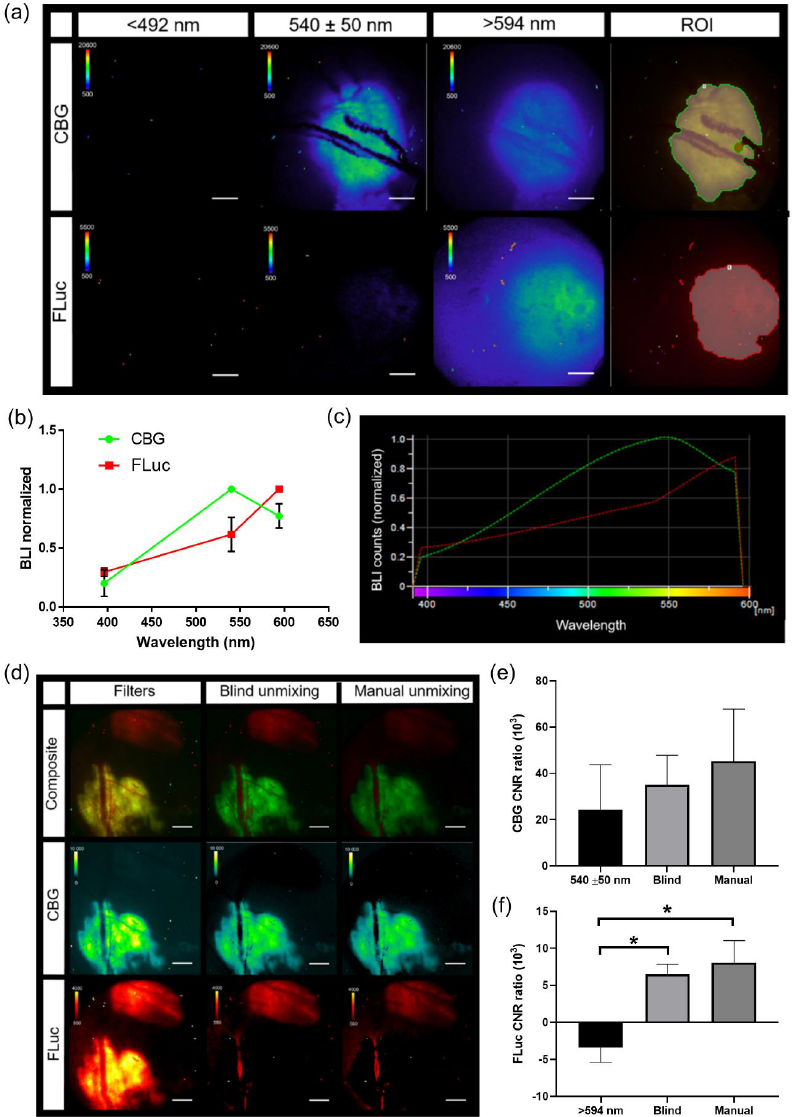
Figure 6. Generation of pure in vivo bioluminescence spectra for spectral unmixing. ( a ) Representative intravital micro-bioluminescence images of individual animals with B16F10 tumors stably expressing either click beetle green (CBG) or Firefly luciferase (FLuc) (BLI, 5 min acquisition, <492 nm, 540 ± 50 nm, and >594 nm filters, 2X objective; scale bar represents 1000 µ m) and auto ROI drawn for collection of pure spectra (ROI). ( b ) Normalized in vivo emission spectra for different bioluminescent reporters, and ( c ) imported user-generated spectral library to unmix CBG and FLuc ( n = 5 animals imaged with CBG, n = 4 animals imaged with FLuc). ( d ) In vivo bioluminescence unmixing of B16F10 tumors; one B16F10 tumor stably expressed ubiquitin-CBG and the other B16F10 tumor stably expressed CMV-FLuc. Representative in vivo bioluminescence image of B16F10 CBG spectrally unmixed from B16F10 FLuc tumors in the same animal within the same window chamber using imaging filters alone (Filters), commercial blind unmixing built into the NIS-Elements software (blind unmixing) and manual unmixing using user-generated spectral library (manual unmixing) following a single i.p. injection of D-Luciferin (BLI, 5 min acquisition, 540 ± 50 nm and >594 nm filters, 2X objective; scale bar represents 1000 µ m). B16F10 CBG was spectrally separated from B16F10 FLuc wherein the composite image shows pseudo-colored B16F10 CBG (green) and B16F10 FLuc (red) tumors within the same window chamber ( n = 4 images (2 animals, 2 imaging time points)). Contrast to noise ratio (CNR) of unmixed signal for ( e ) CBG and ( f ) FLuc using filters alone, blind unmixing and manual user-generated spectra ( n = 4 images; * p <